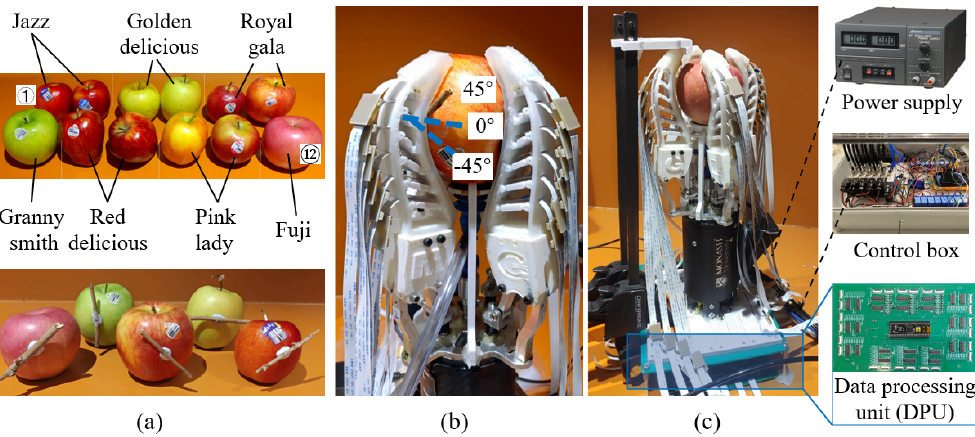
Figure 7. Experiment setting of the grasping statuses detection: ( a ) Apples and branch orientation settings; ( b ) branch interfered grasp; ( c ) finger obstructed grasp.